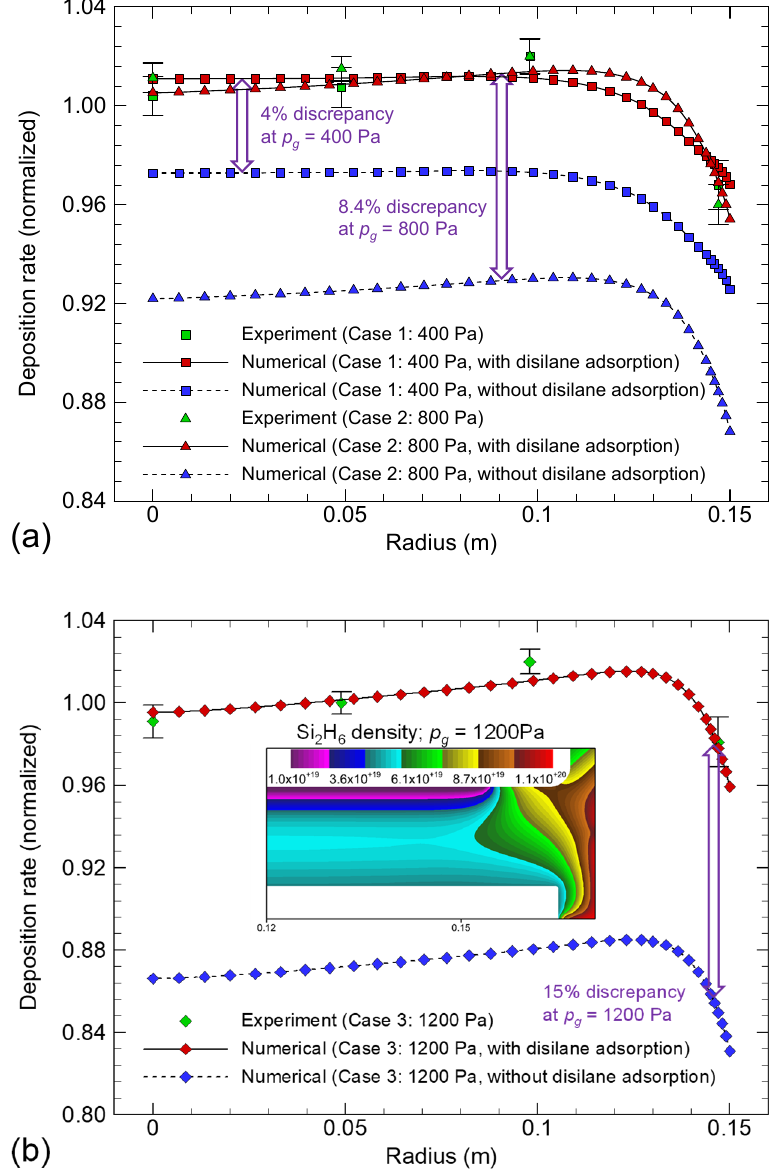
Figure 12. Deposition rates are plotted along the radial direction for p g = 400 Pa (squares), 800 Pa (triangles) and 1200 Pa (diamonds). ( a ) Deposition rate profiles for p g = 400 and 800 Pa superimposed with the corresponding experimental data. ( b ) Relative discrepancy of approximately 15% at p g = 1200 Pa between the deposition rates with and without consideration of Si 2 H 6 adsorption.